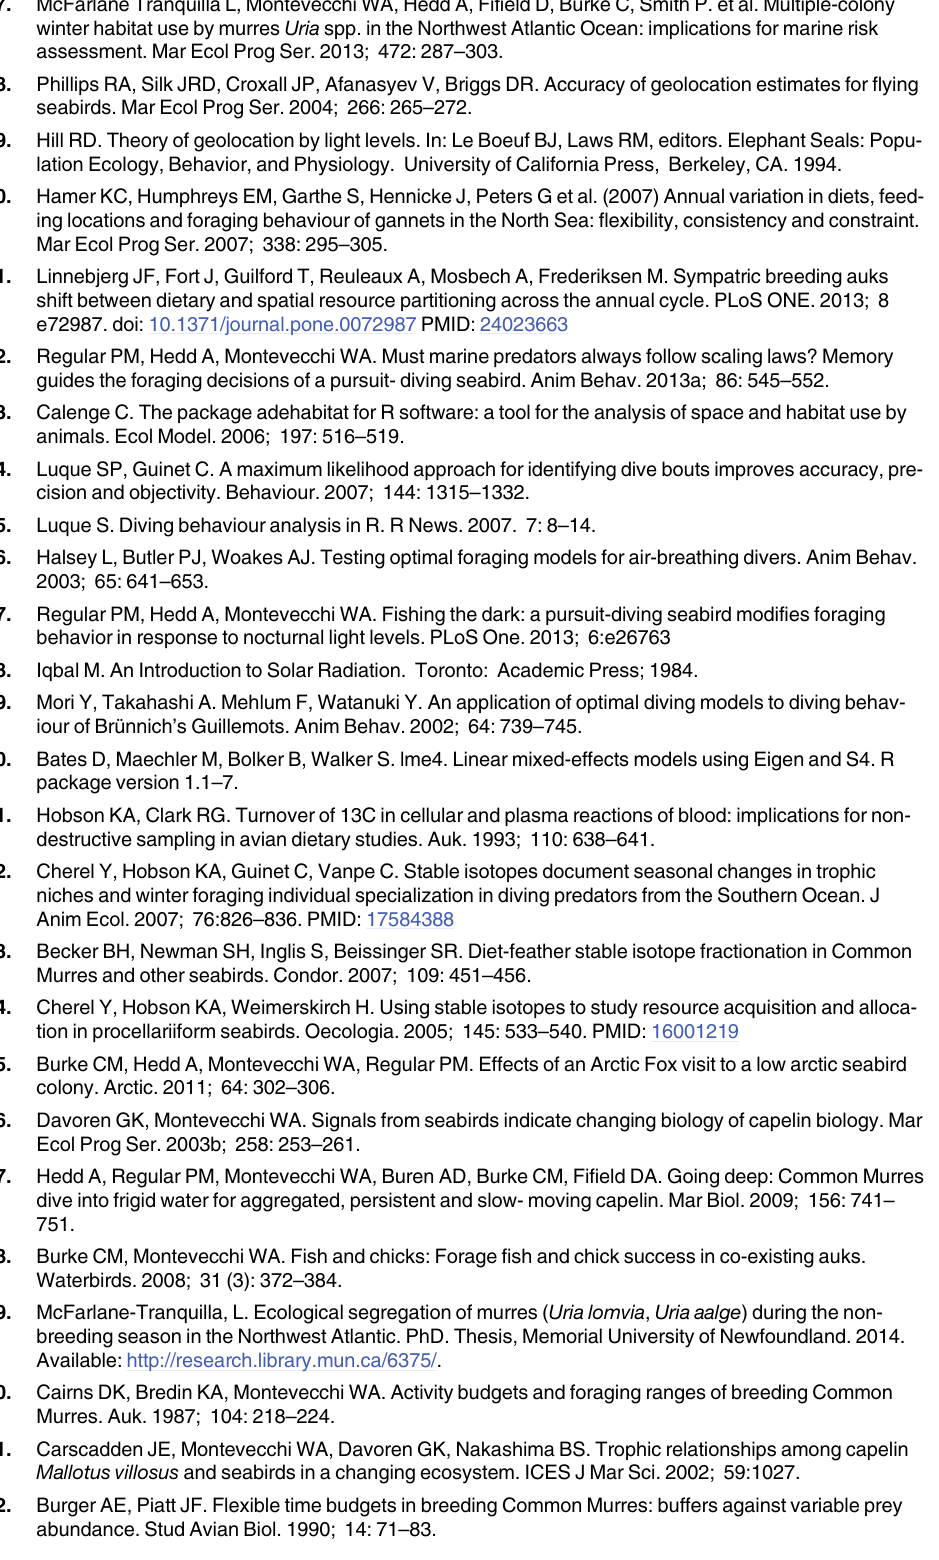
PLOS ONE | DOI:10.1371/journal.pone.0141190 November 17,